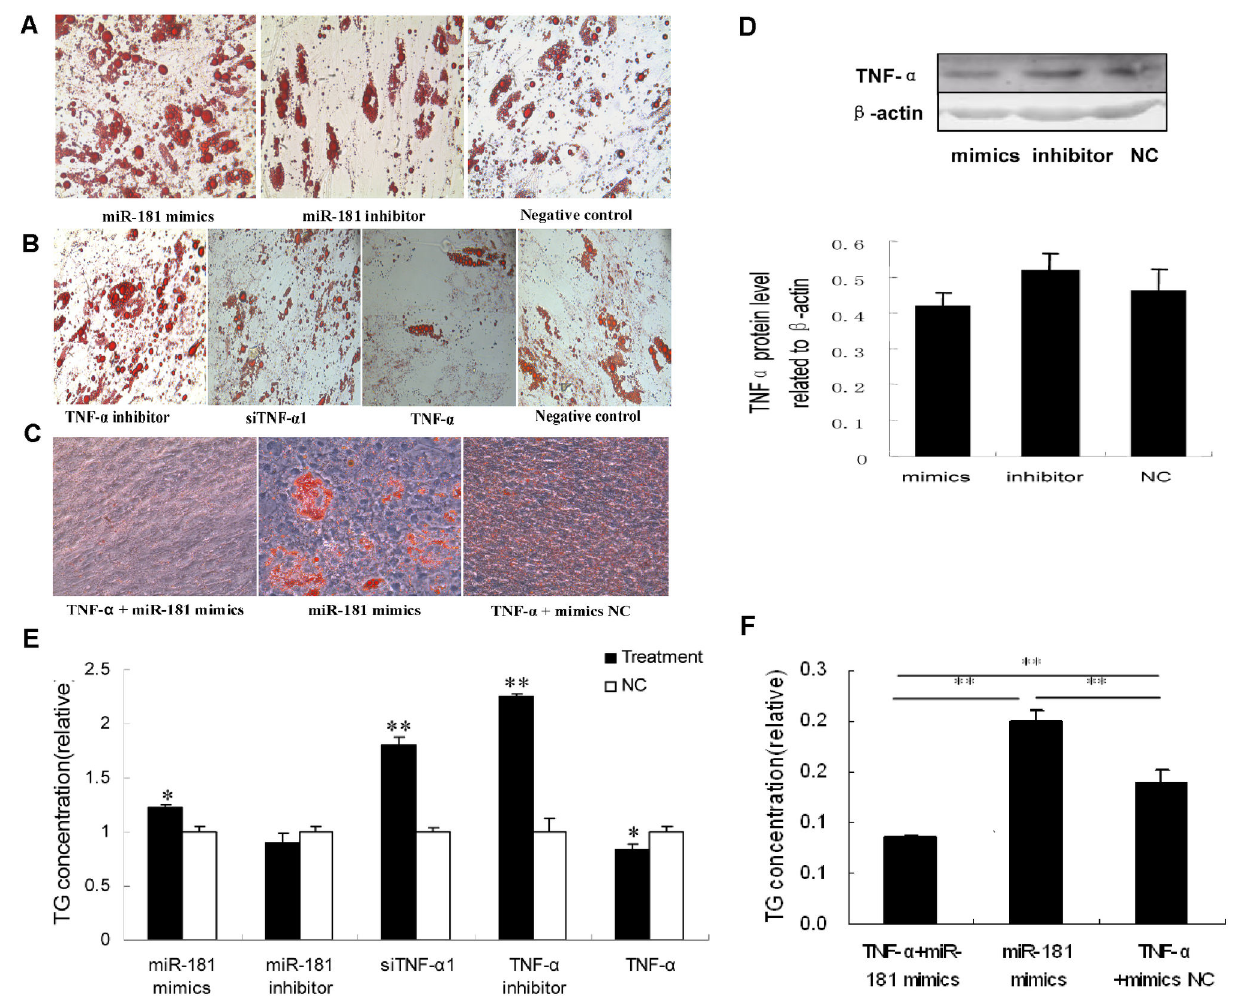
Figure 5. Changes in miR-181a levels modulate adipocyte differentiation. After transfection of protected miR-181a mimic or inhibitor, pre-adipocytes were stimulated to differentiate, taking TNF-α siRNA, TNF-α inhibitor and TNF-α as the reference or cotransfected controls. After 8 days, cells were harvested for analysis. (A) Formation of lipid droplets in the cells that transfected with miR-181a mimics and inhibitor were observed by staining with Oil Red O. (B) Formation of lipid droplets in the cells that treated with TNF-α siRNA, TNF-α inhibitor and TNF-α were observed as miR-181a treatment. (C) Formation of lipid droplets in the cells that contransfection with TNF-α were observed as miR-181a mimics treatment. (D) TNF-α protein abundance 8 days post-induction was assessed by Western blot analysis and quantified using gray scale scanning. (E,F) The degrees of differentiation in concorresponding to Figure 5B,5C treatment, respectively, were also determined by measuring the TG level, represented as the means SD, and each sample was assayed in triplicate (* P < 0.05, ** P < 0.01,